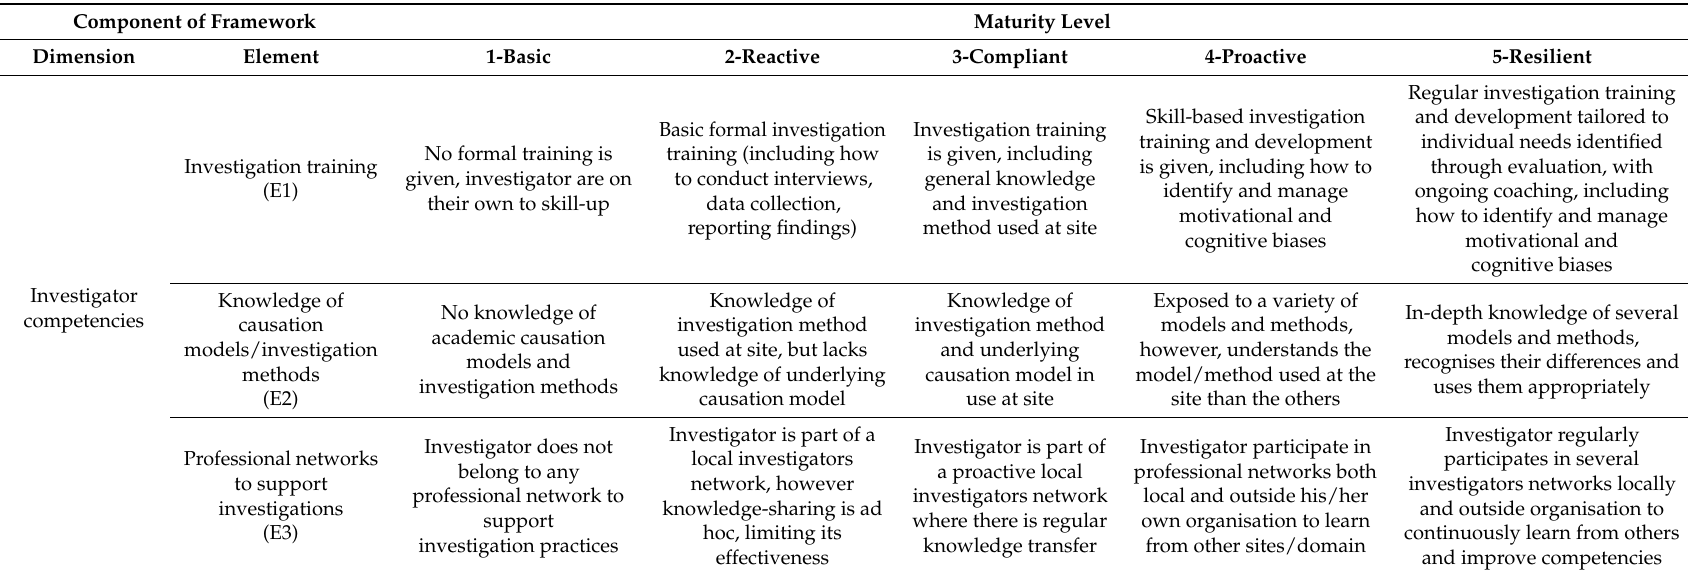
Table 1. Framework for assessing maturity of investigator